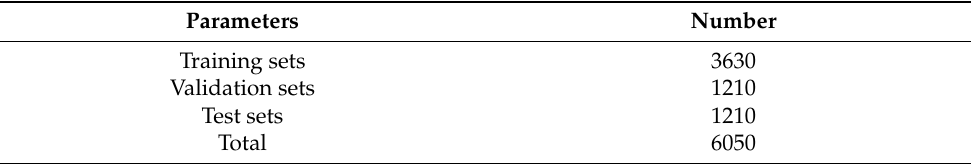
Table 1. Distribution of data sets.